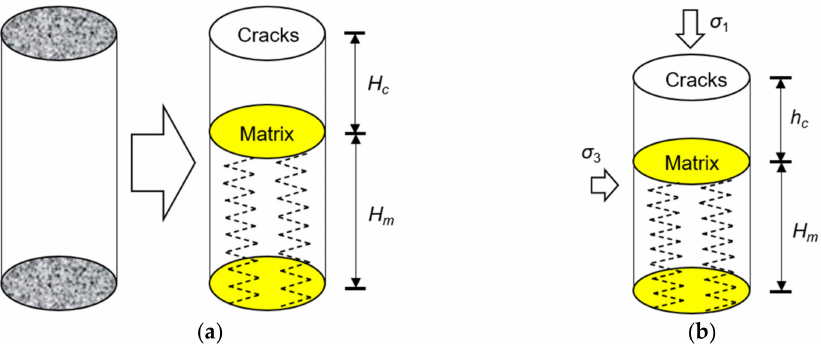
Figure 4. Schematic of rock deformation analysis: ( a ) mesoscopic treatment of rock; ( b ) rock deforma- tion after